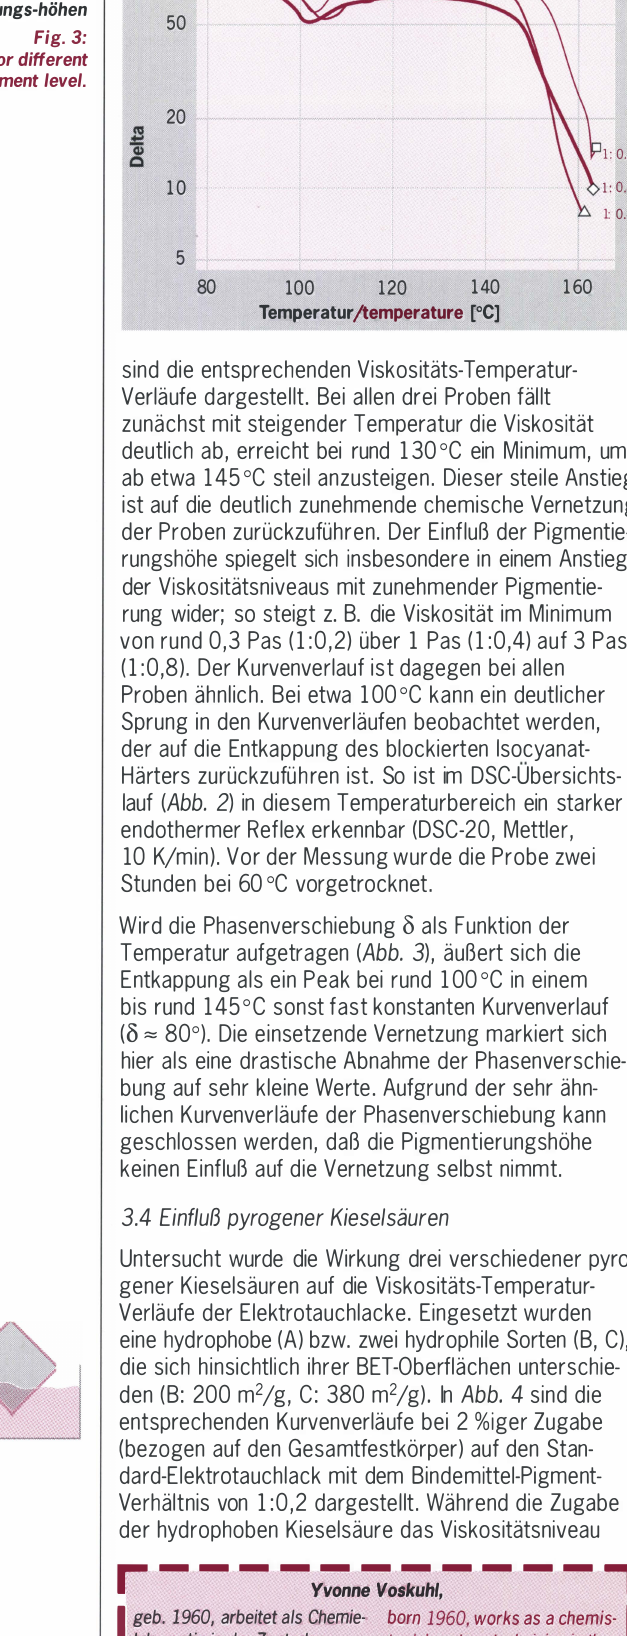
Fig. 3: Phase shift 8 for different pigment